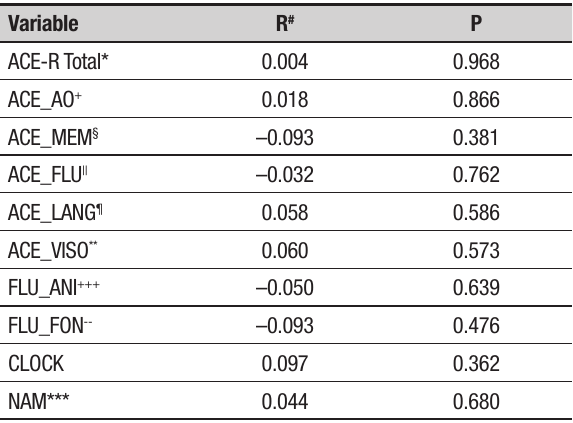
Table 3. Correlation test for ACE-R and its domains with Geriatric De- pression Scale (GDS-15) in 91 elders treated at the reference clinic of a mental health program under the Family Health Strategy of Porto Alegre- RS,